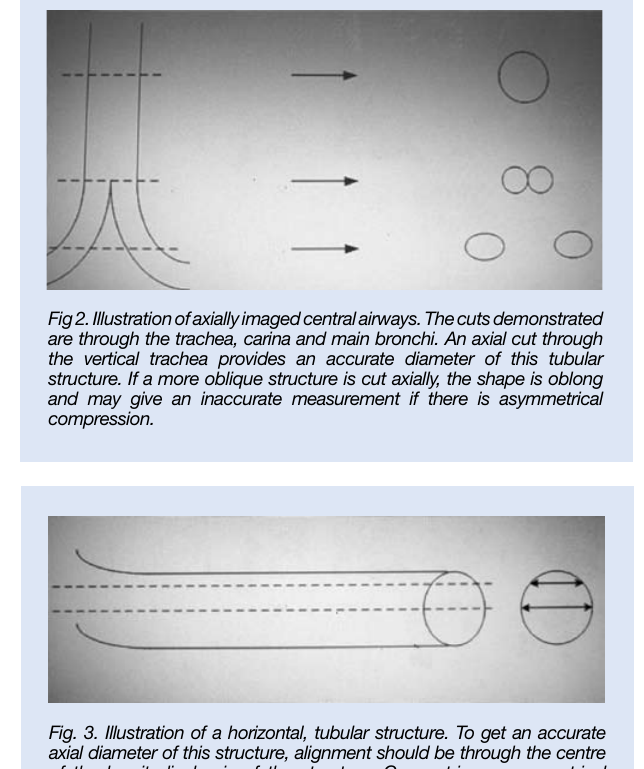
Graph 7. Comparison between measurements in soft tissue and lung windows in the bronchus intermedius  ICC(agreement)=0.530 ICC(consistency)=0.889 x=y line